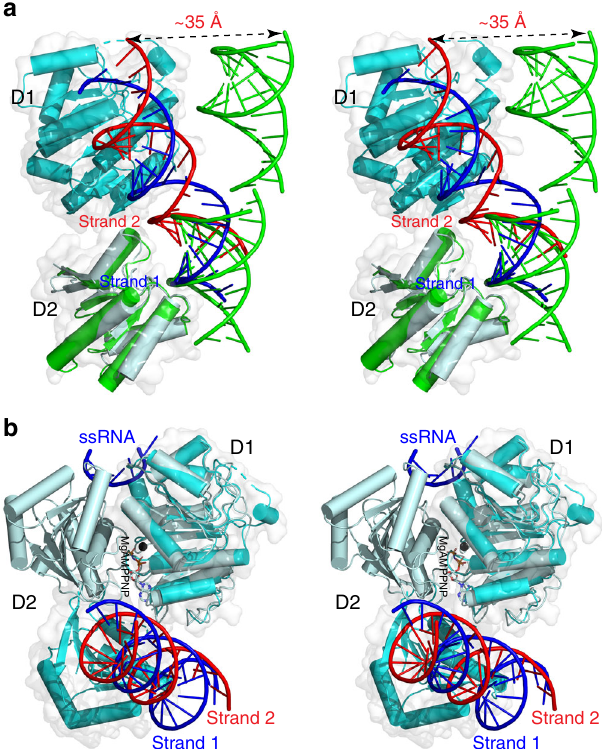
Fig. 3 Substrate recognition by the D1D2 core of DEAD-box helicases. a In stereo, the superimposition of the D2:dsRNA complex of Mss116p (in green, PDB entry 4DB2) with the D1D2:dsRNA:D1D2 complex of DDX3X (D1 in cyan, D2 in palecyan, RNA strands in red and blue, this work). The two structures are aligned based on D2 and are illustrated as cartoon models. The D1D2 core of DDX3X is also outlined with a transparent molecular surface in white. The double-headed arrow indicates a distance of ∼ 35 Å. b In stereo, the superimposition of the D1D2:ssRNA:MgAMPPNP complex of Vasa (protein in palecyan, RNA in blue, Mg in black, and AMPPNP in atomic color; PDB: 2DB3) with the D1D2:dsRNA:D1D2 complex of DDX3X (protein in cyan, RNA Strand 1 in blue and Strand 2 in red; this work). The two structures are aligned based on D1 and are illustrated as cartoon models. The D1D2 core of DDX3X is also outlined with a transparent molecular surface in white. RNA Strand 1 (in blue) is recognized by both D1 and D2 in the two structures. The single-stranded RNA (ssRNA) in the D1D2:ssRNA:MgAMPPNP structure (PDB: 2DB3) corresponds to part of the Strand 1 in the D1D2:dsRNA:D1D2 structure (this (Fig. 3a). Superposition of the D1D2:dsRNA:D1D2 assembly and the D2:D2:pseudo-dsRNA:D2:D2 ensemble on the basis of one D2 in each structure shows dramatically different arrangements of RNA and protein domains (Supplementary Fig. 4). Our structure suggests that if the D1 of Mss116p were present, it would bind Strand 1, and the arrangement of RNA and protein domains could be dramatically improved.